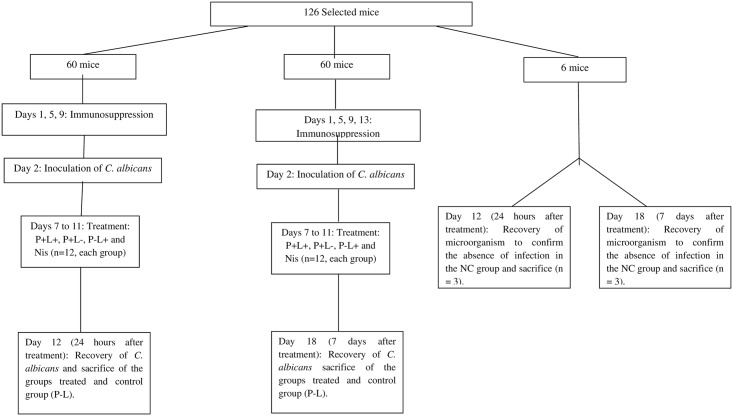
Study design: Tetracycline hydrochloride was given in drinking water during days 1 to 18; the P+L+ group corresponded to the animals treated with PDZ and LED light (P+L+); the P-L+ group corresponded to evaluation of LED light alone; the P+L- group corresponded to evaluation of the PS alone; the P-L- group corresponded to infected animals that did not receive any treatment; the NC group corresponded to the healthy and untreated animals.